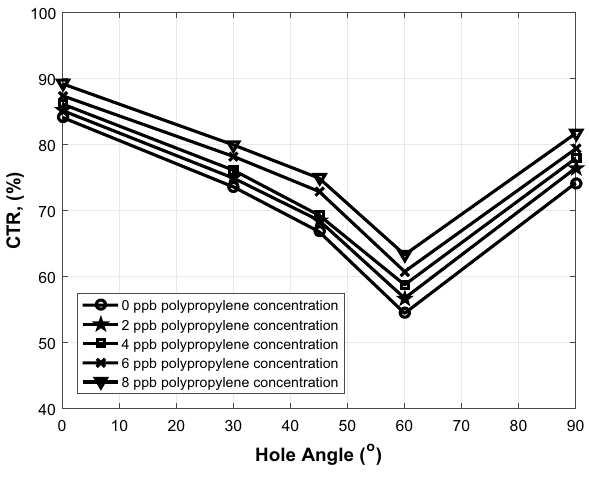
Fig. 5 Cutting transport ratio vs. hole angle for cuttings size of 0.5– 1.0 mm and pipe rotation of 120 RPM